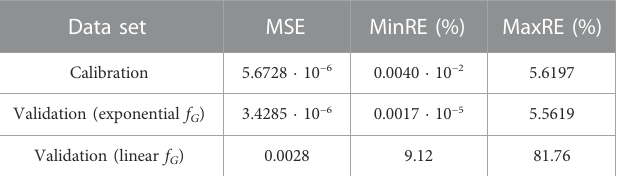
TABLE2Performancemetricsusingthecalibrationandvalidationsetsafterusing the exponential and linear f G (Eqs 4, 27,